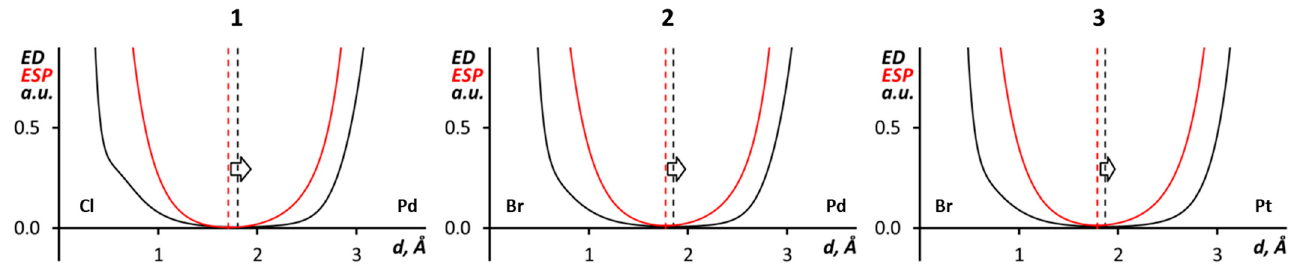
Figure 9. The ED and ESP 1D profiles along the M ∙∙∙ X bond paths for the ( 1 ) 2 (left), ( 2 ) 2 (middle), and ( 3 ) 2 (right) dimeric clusters of type II.